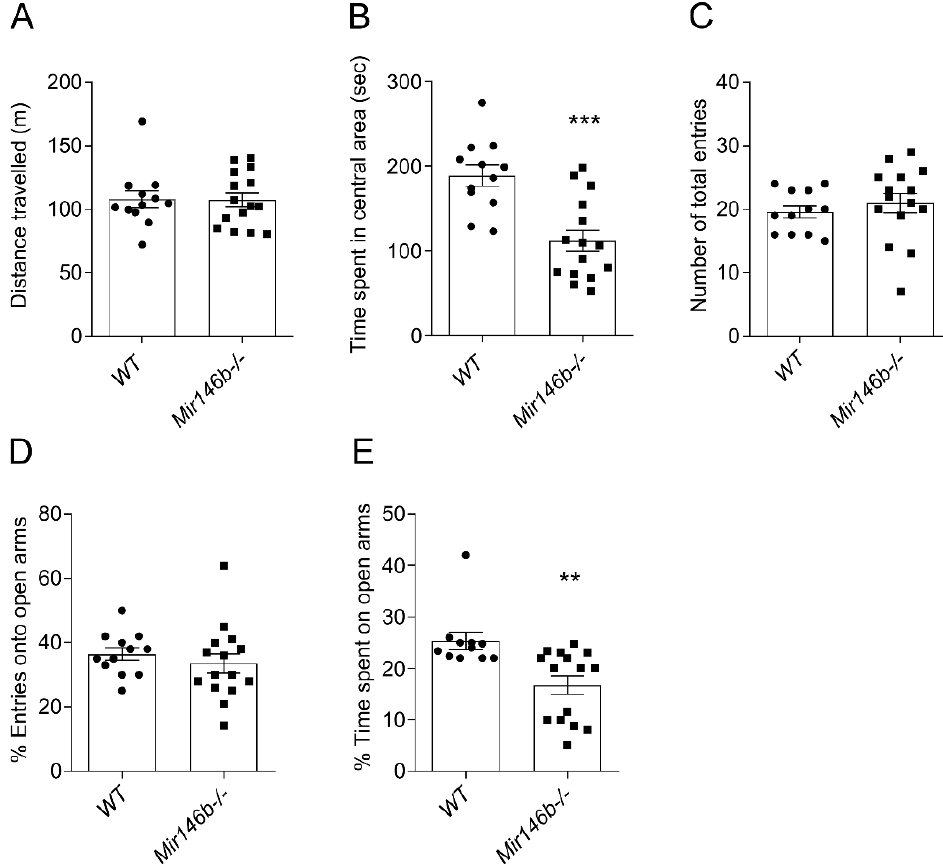
Figure 3. miR-146b deficiency causes anxiety-related behaviors. ( A ) Total distance travelled (locomotor activity). ( B ) Time spent in the central area of the open field test. ( C ) Total number of entries. ( D ) Percentage of entries onto the open arms. ( E ) Percentage of time spent on the open arms of elevated plus maze of Mir146b -/- mice and their WT littermates. Number of animals = 11–15, Student’s t -test. Data represented as mean ± SEM; ** p < 0.01, *** p < 0.001.